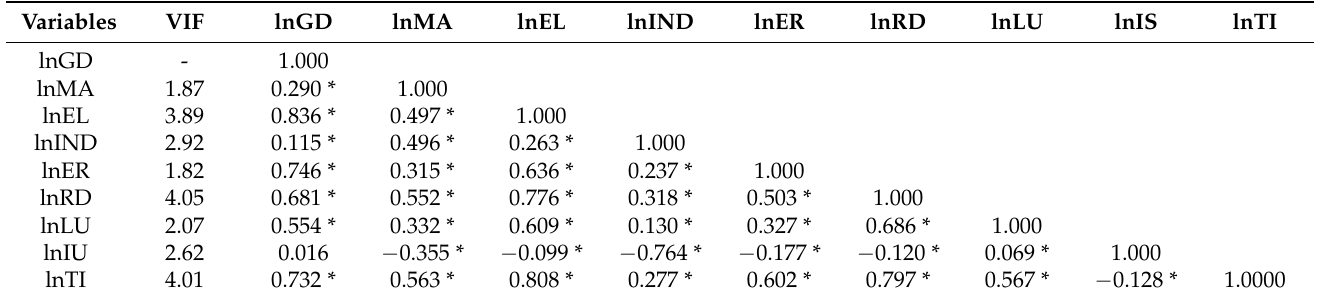
Table A2. Multicollinearity Tests and Correlation Coefficient between